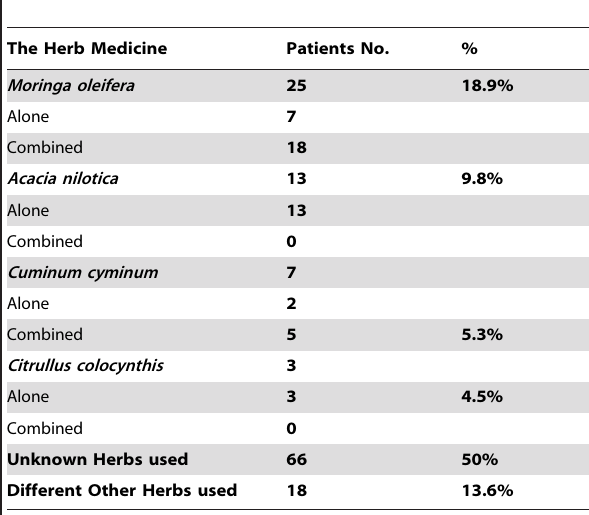
Table 2. The prevalence of different herbs used among the study